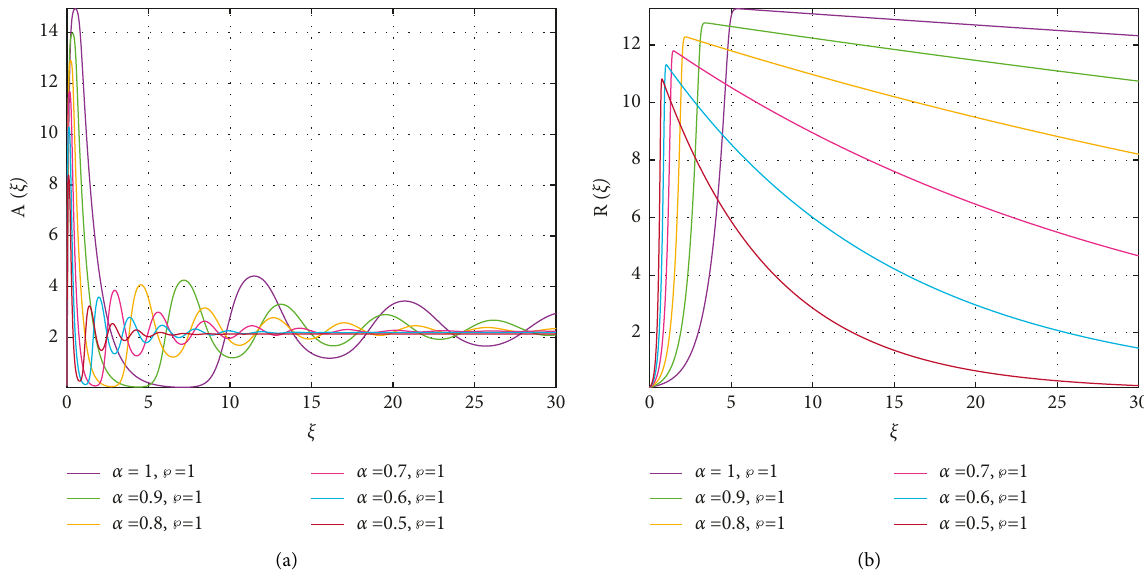
Figure 11: (a) Displays of addicted individuals S ( ζ ) (b) Displays of recovered individuals E ( ζ ) using a another numerical approach for decreasing fractional-order α and fixed fractal-dimension ℘ � 1.